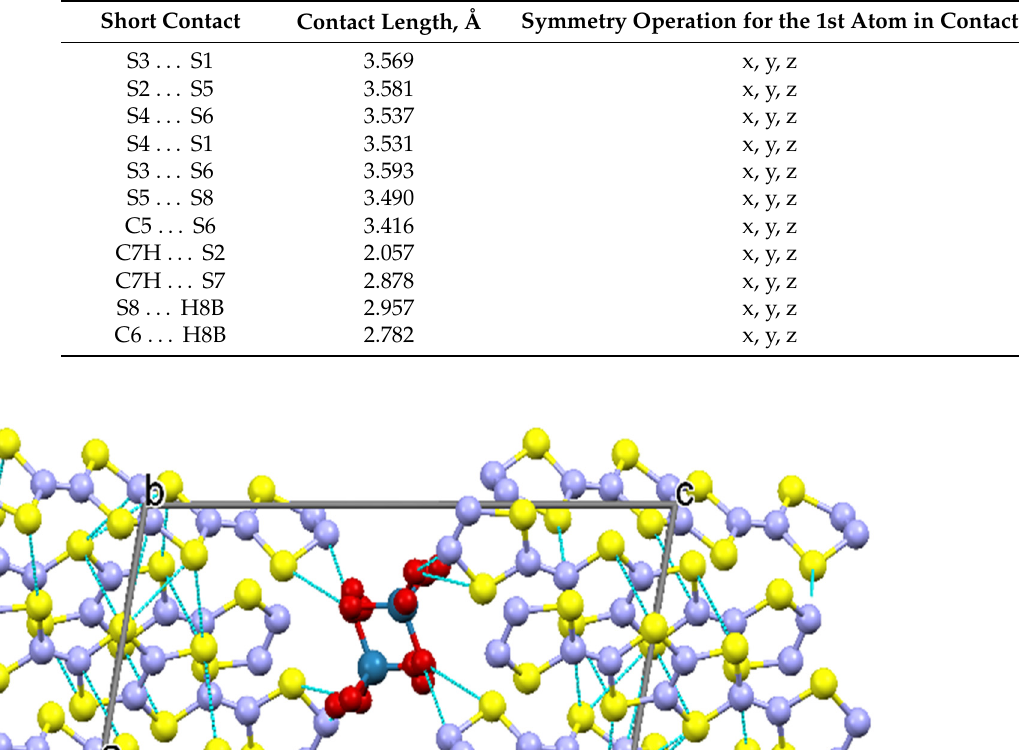
Table 2. Short intermolecular contacts in the structure of the salt 2.